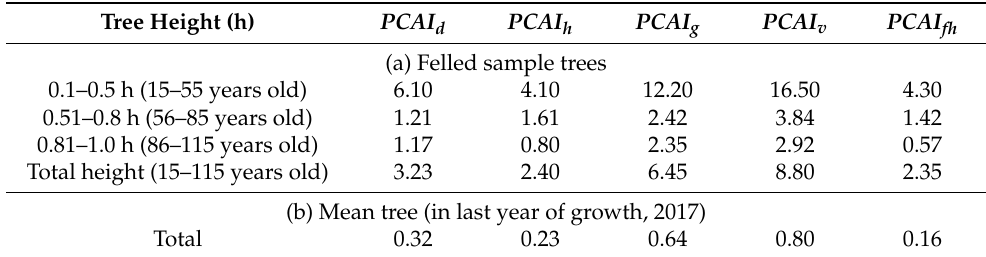
Table 3. Annual mean percentages of mean fir